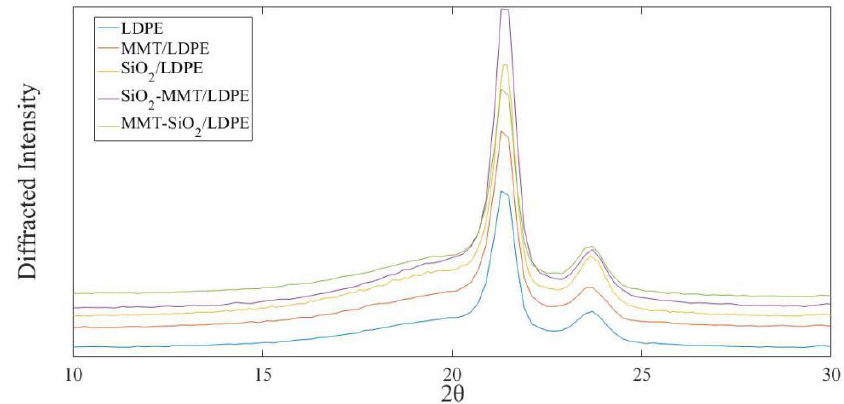
Figure 4. XRD curves of each sample. Table 2. XRD parameters of each sample.